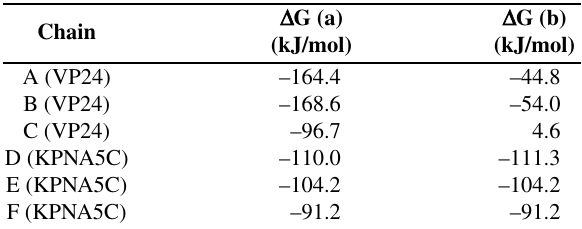
Table 1: (a) The interaction free energy of the complex’s chain with the rest of the VP24:KPNA5C complex. (b) The interaction free energy for each of the complex chain with the rest of the VP24 trimer.